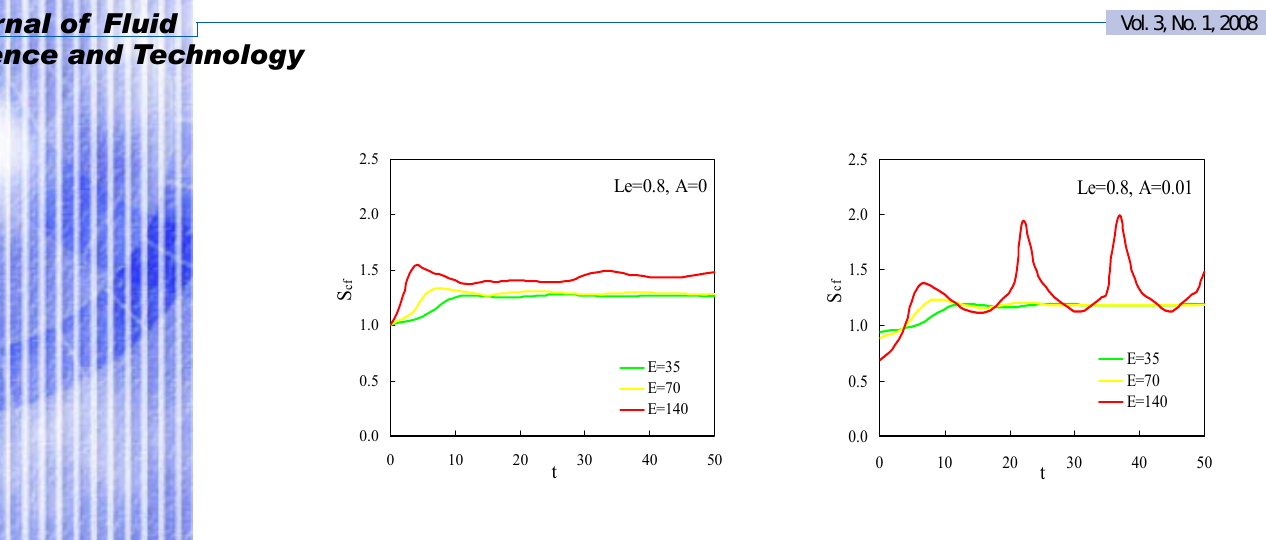
Fig. 10. Time histories of burning velocities of cellular flames at Le = 0.8 at E = 35, 70 and 140 under the adiabatic and non-adiabatic conditions.